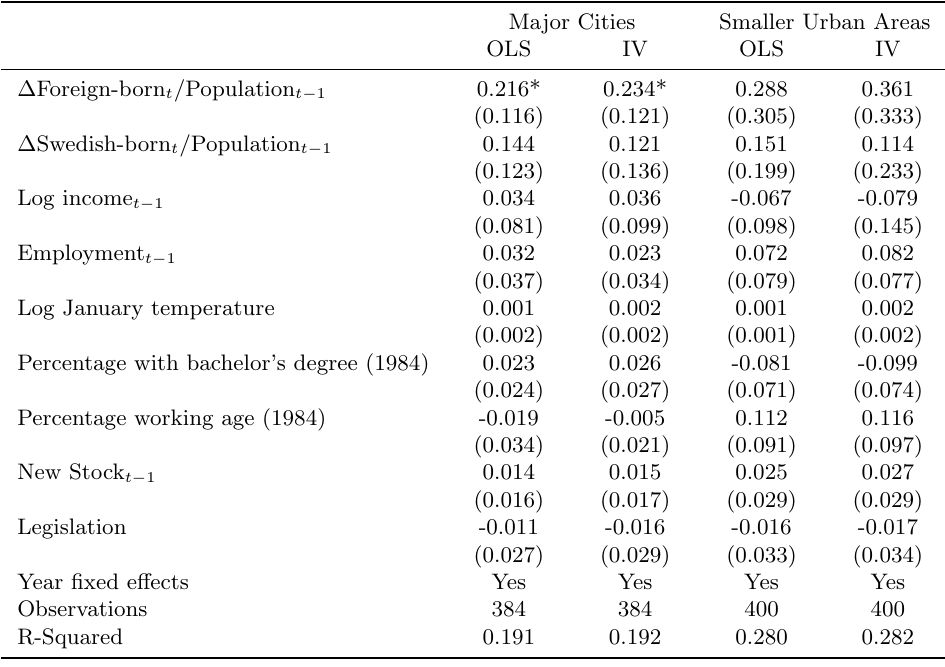
Table 3: The relationship between migration and rental levels in different types of